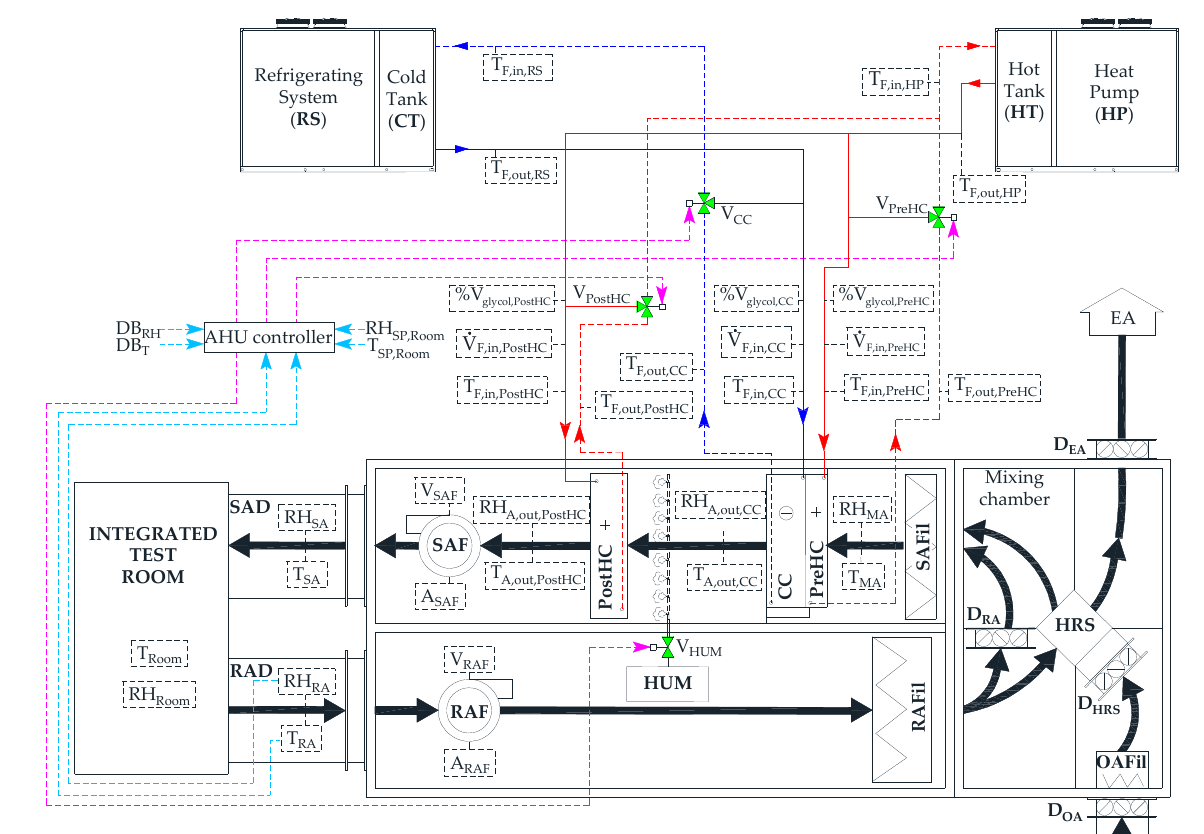
Figure 1. Schematic of the HVAC system. Table 1. Characteristics of the main AHU components.